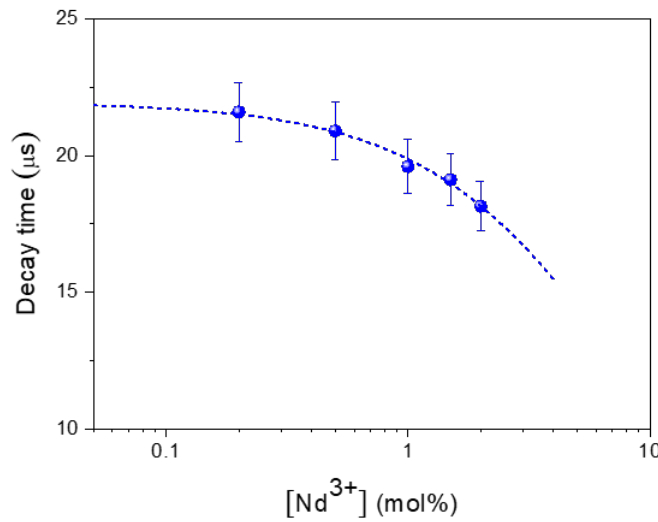
Figure 6. Concentration dependence of the experimental decay times. Dashed line represents the least squares fitting to Equation (1). Error bars have been included.